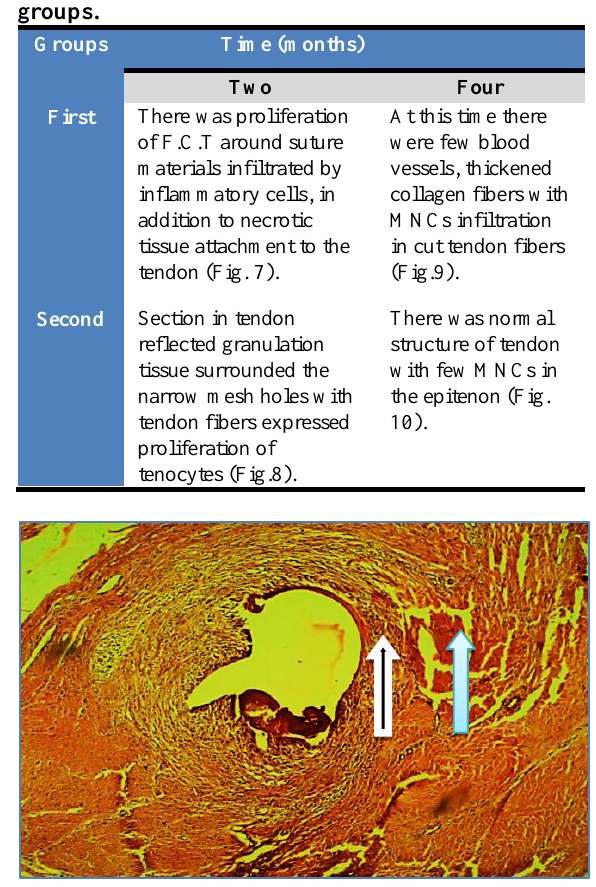
Figure, 7: Histopathological section in tendon of first group, 2 months post-suturing shows fibrous connective tissue proliferation around suture materials infiltrated by inflammatory cells (black arrow) in addition to necrotic tissue attachment to the tendon (blue arrow) (H&E stain;